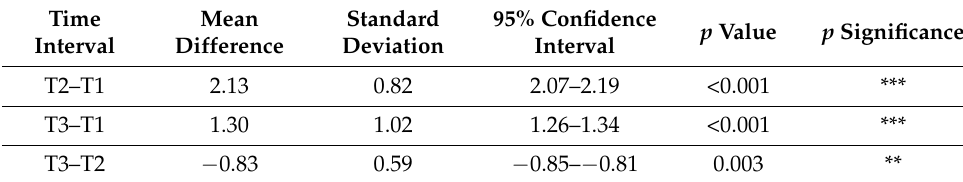
Table 2. Results of the mean differences (mm) of Nasal Width 1 in the three time intervals.